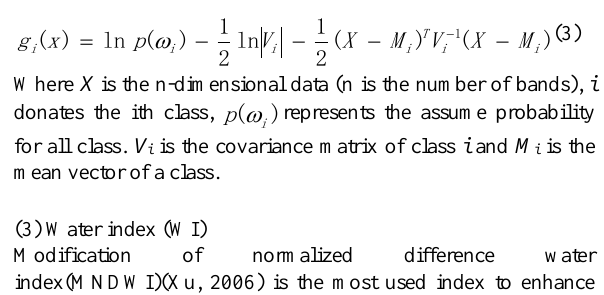
Figure 1. The Landsat8 OLI images used in this